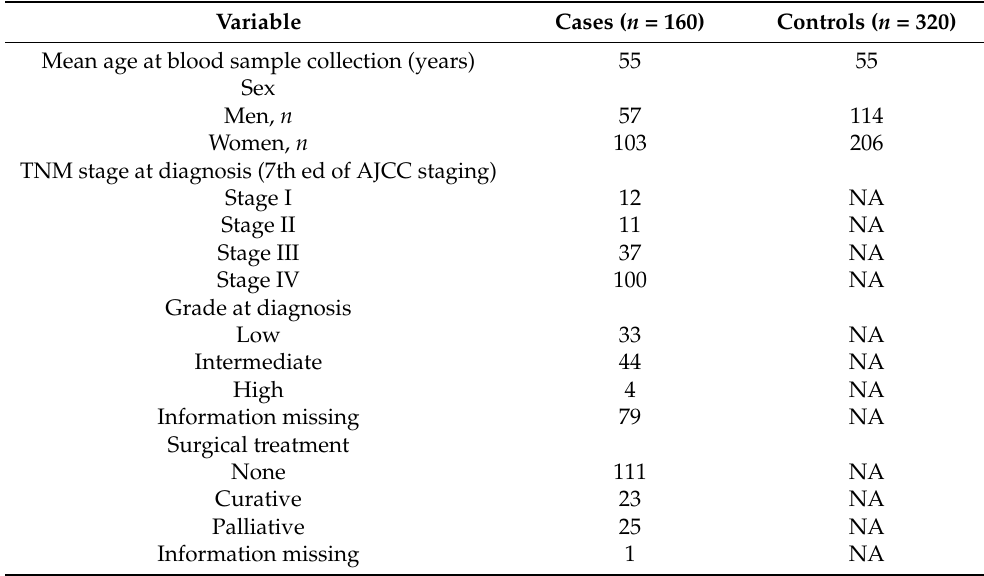
Table 1. Clinical characteristics of pre-diagnostic cohort.